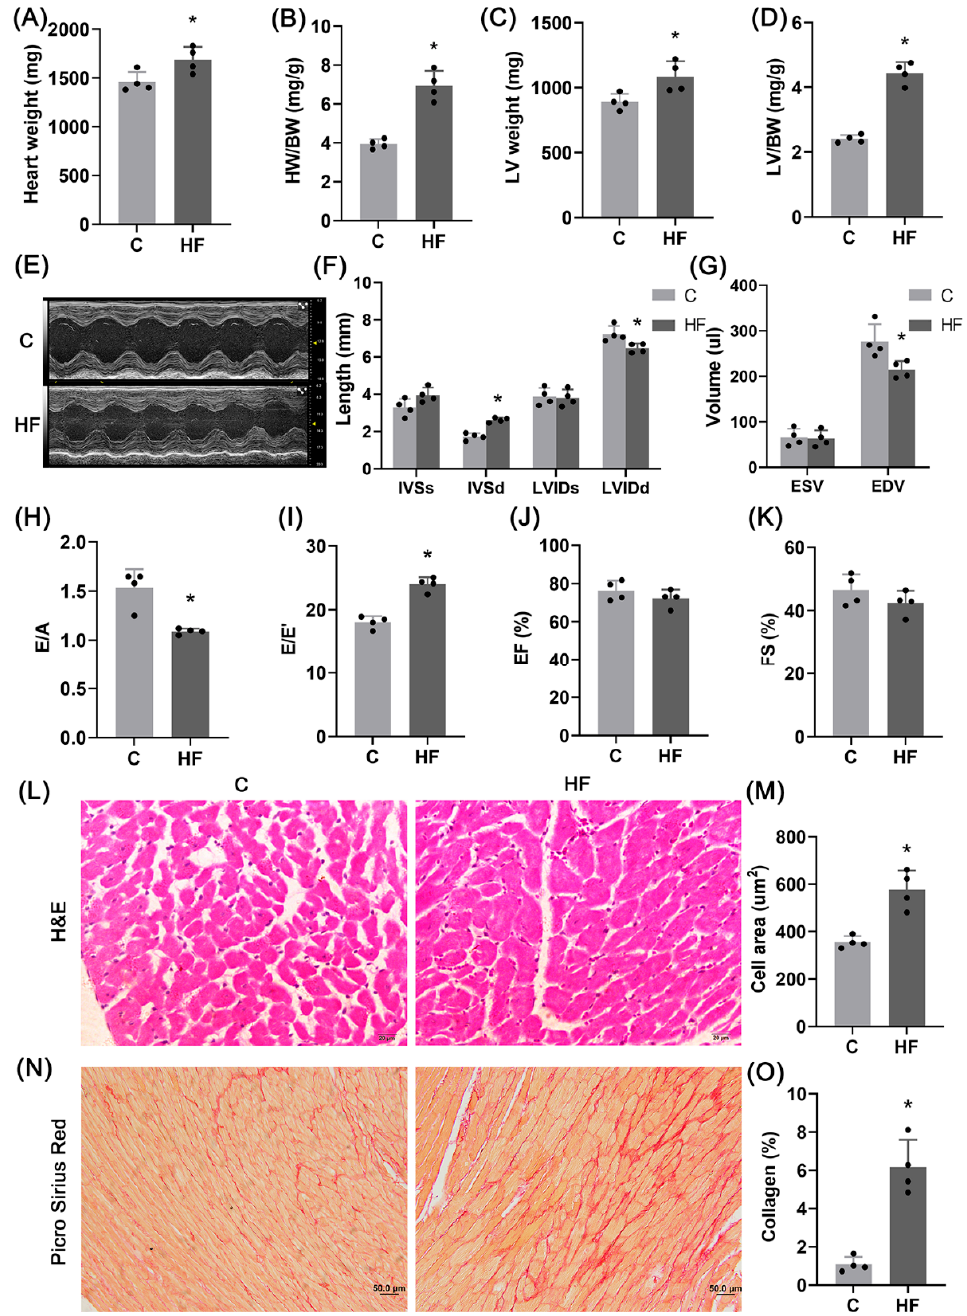
Figure 1. Hypertension-induced HFpEF model. ( A – D ) Heart weight ( A ), ratio of HW to BW ( B ), LV weight ( C ), and ratio of LV weight to BW ( D ); n = 4 per group. ( E – K ) Representative images of M-mode ultrasound ( E ), interventricular septal end systolic thickness (IVSs), interventricular septal end diastolic thickness (IVSd), LV end systolic internal diameter (LVIDs), LV end diastolic internal diameter (LVIDd) ( F ), end-systolic volume (ESV), end-diastolic volume (EDV) ( G ), E/A ( H ), E/E’ ( I ), ejection fraction (EF) ( J ), and fraction of shortened (FS) ( K ); n = 4 per group. ( L , M ) Representative images of LV H&E staining ( L ) and quantitative analysis of myocardial cell area (4 samples per group, 3–5 fields of view per sample, Scale bar: 20 μ m) ( M ). ( N , O ) Representative images of Picro Sirius Red staining ( N ) and quantitative analysis of collagen fiber area fraction (4 samples per group, 3–5 fields analyzed per sample, Scale bar: 50 um) ( O ). The data are mean ± SD, * Compared with the C group, p < 0.05.